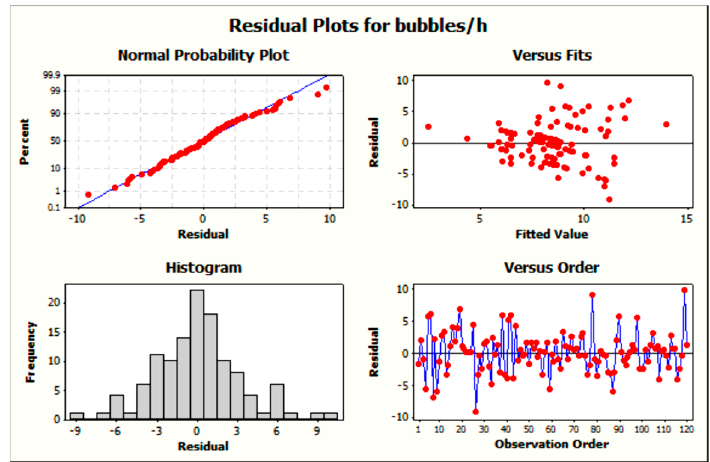
Figure 31. Residual plots for bubbles/h.